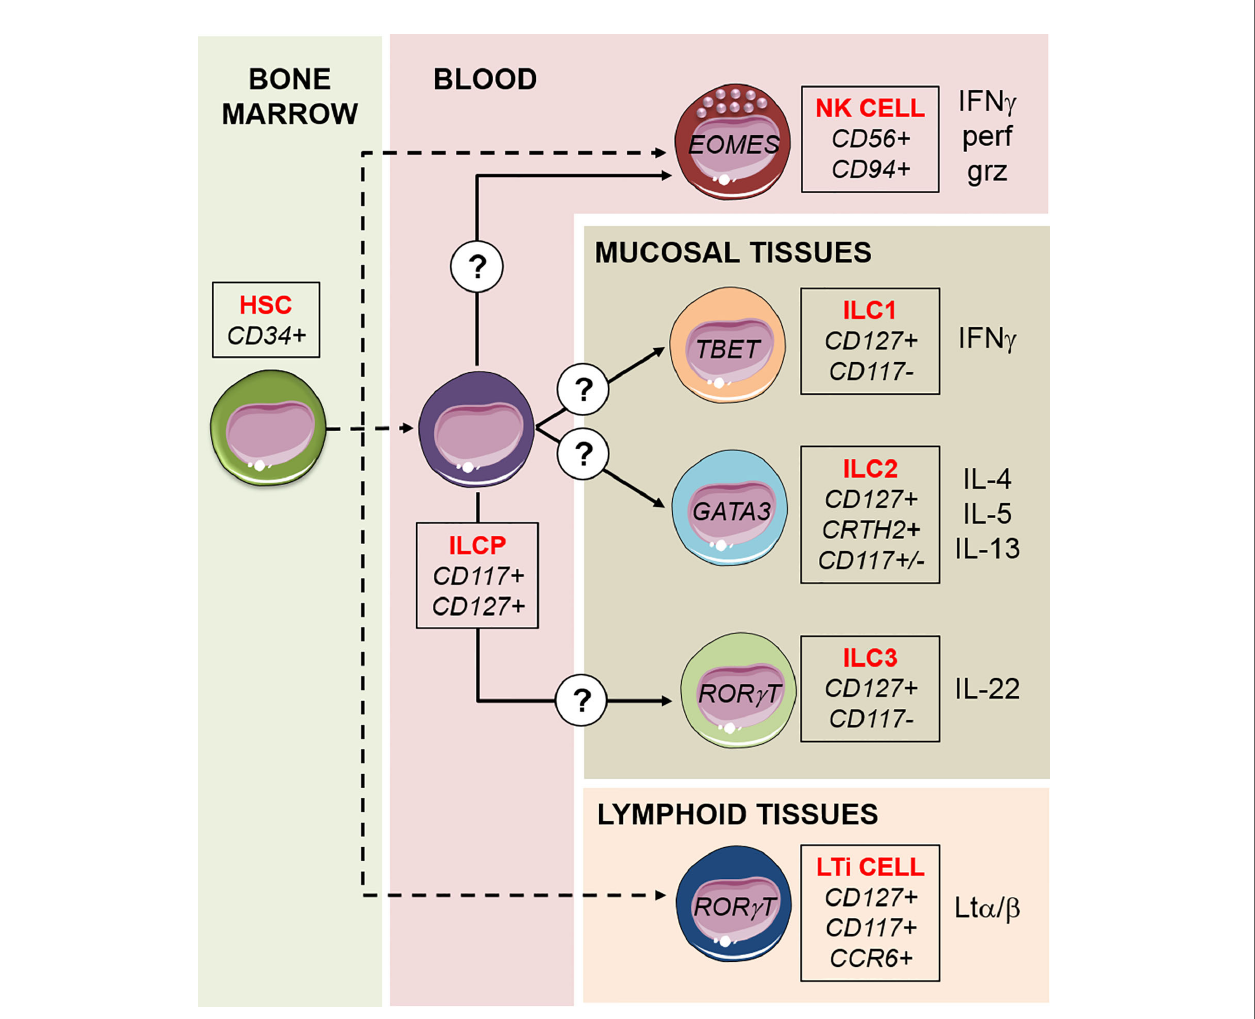
FIGURE 1 | Schematic model of ILCs development. ILCs differentiation proceeds by steps and begins with the hematopoietic stem cell (HSC) in the bone marrow, via intermediate lymphoid restricted precursors (dashed lines). A common ILC precursor (ILCP) circulating in the peripheral blood harbors multipotent capacity to generate NK cells, ILC1s, ILC2, and ILC3s, in response to not completely understood signals. LTi cells are a fi fth subset of ILCs, they have a different developmental path compared to the other ILCs and have a crucial role during embryonic development for the formation of lymphoid structures. For each subset, transcription factors, surface markers, and cytokines released are indicated. NK cells are the only “ cytotoxic ” ILCs, capable of killing target cells through the exocytosis of lytic granules containing perforin (perf) and granzyme